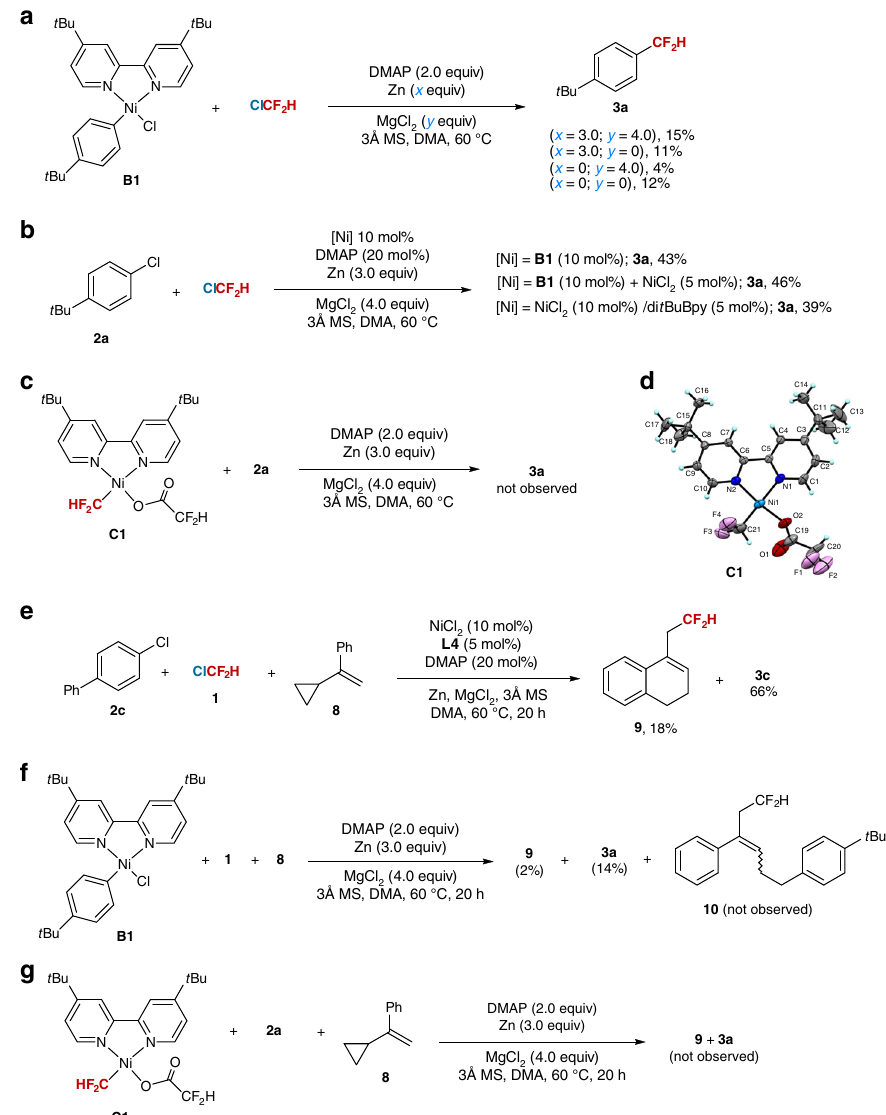
Fig. 4 Mechanistic studies. a Reaction of nickel complex B1 with ClCF 2 H. b B1 or NiCl 2 /di t BuBpy catalyzed reaction of 2a with ClCF 2 H. c Reaction of C1 with 2a . d X-ray crystal structure of C1 . e Experiments to trap the di fl uoromethyl radical by reaction of 2c and 8 with ClCF 2 H. f Reaction of B1 and 8 with ClCF 2 H. g Reaction of 2a and 8 with